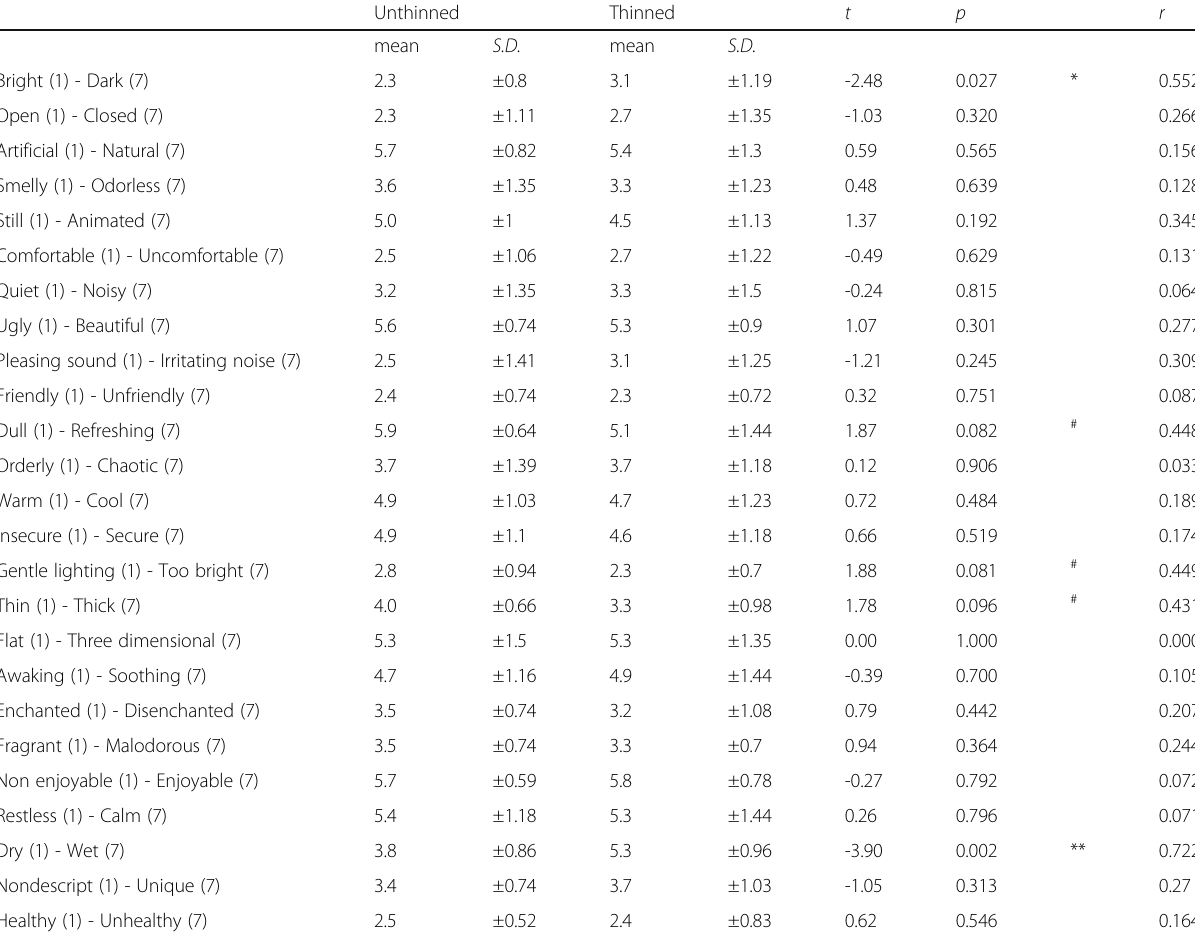
Table 5 Results of t -test comparison between unthinned and thinned settings (Semantic Differential Method) Unthinned